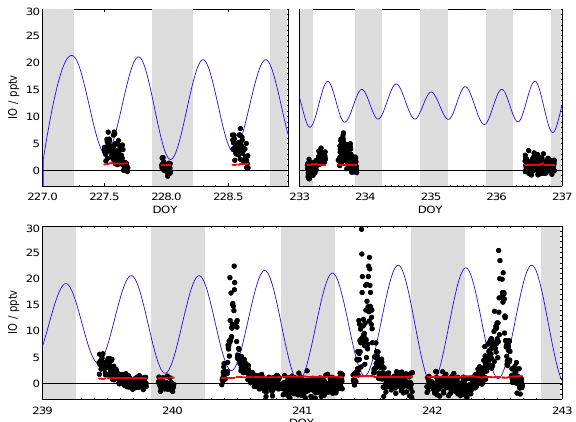
Fig. 3. IO mixing ratio (pptv) observed by LIF for a 60s time in- tegration period (black) for the Day of Year (DOY) in 2007; IO instrument 60s limit of detection ( ∼ 1.4pptv at 2 σ ) (red); predicted tide height at Roundstone Bay (blue) scaled to fit the graph. Shaded areas indicate night-time observations. Data were collected between 15 (DOY 227) and 30 August (DOY 242) 2007.